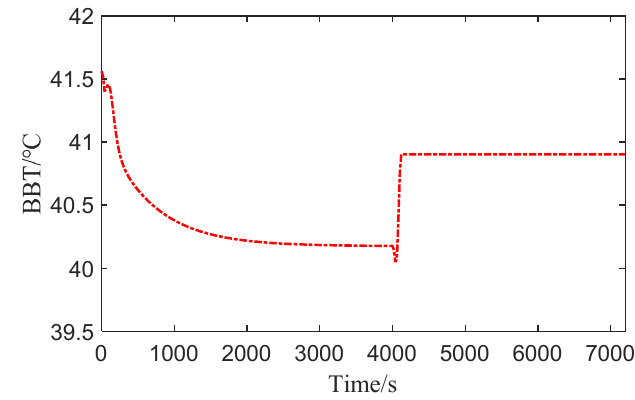
Figure 29. Dynamic of BBT for step increase in T steam .